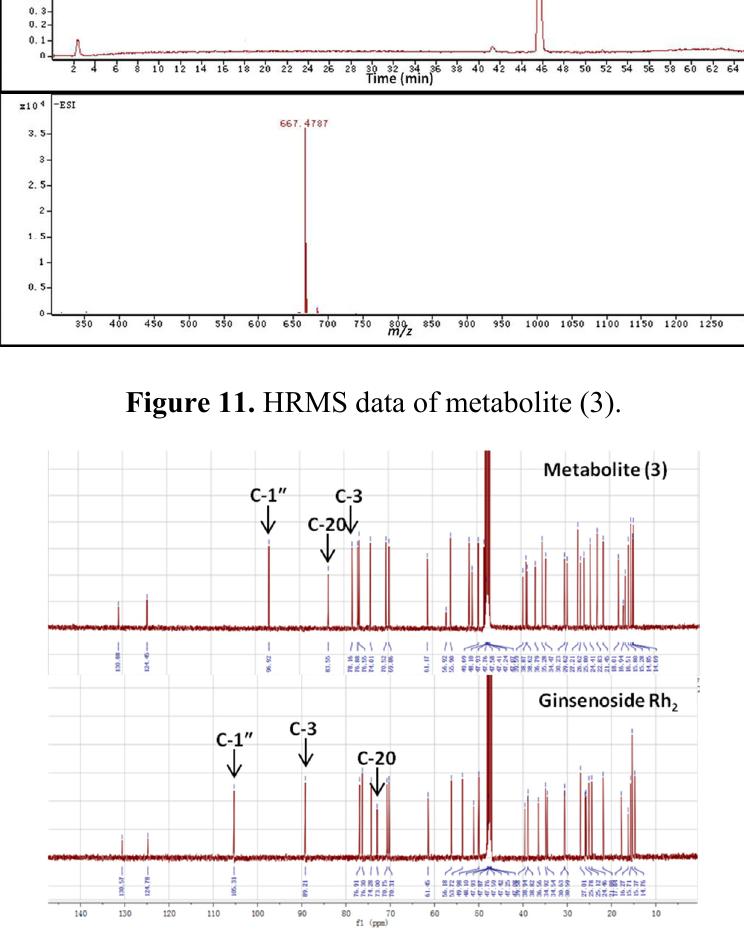
Figure 12. NMR differences between metabolite 3 and ginsenoside